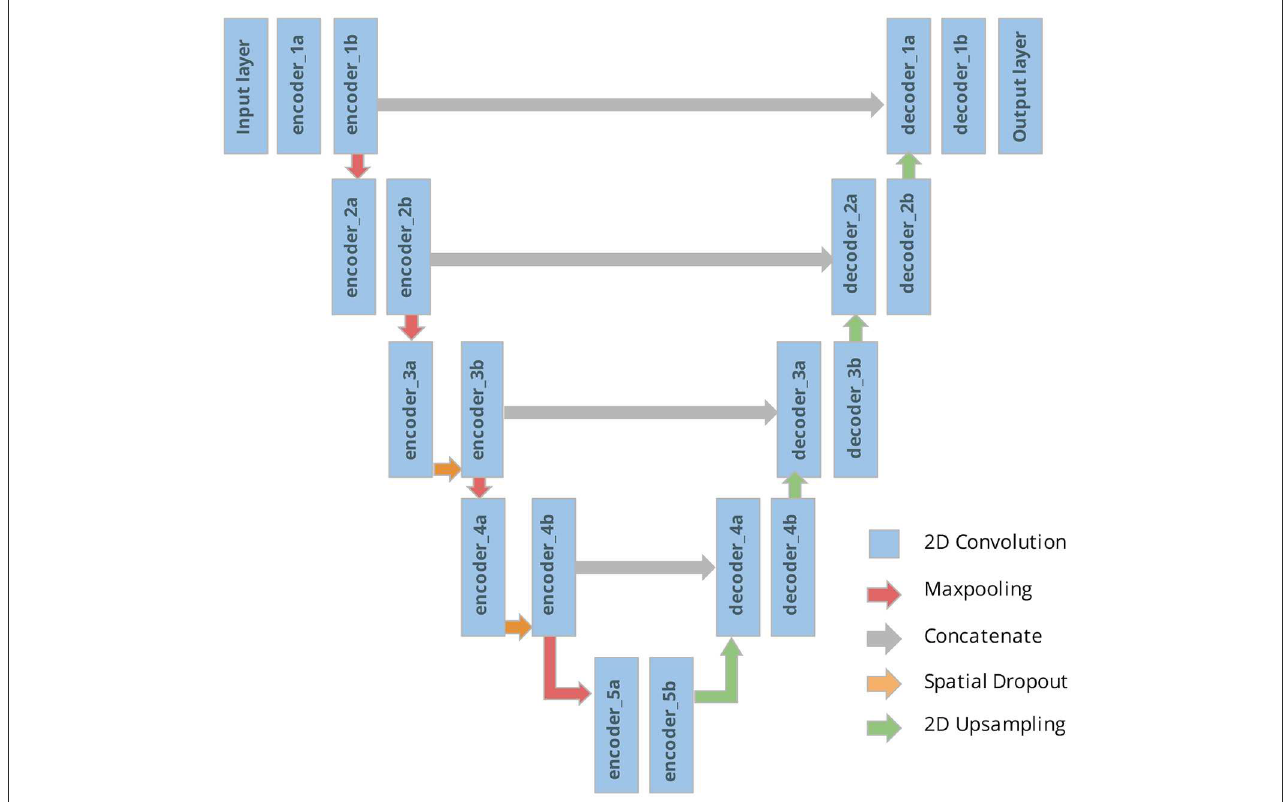
FIGURE5 U-Net architecture with our naming system of the different tunable layers considered for the pBNN.